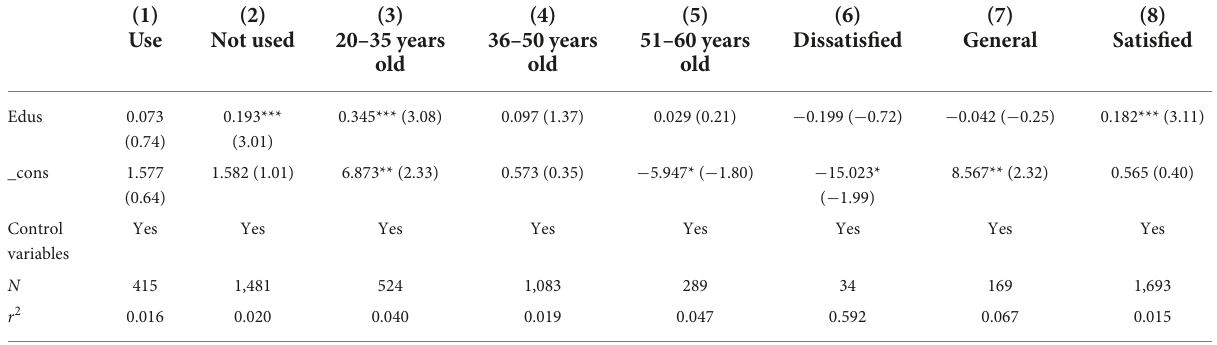
TABLE 6 Heterogeneity analysis results.